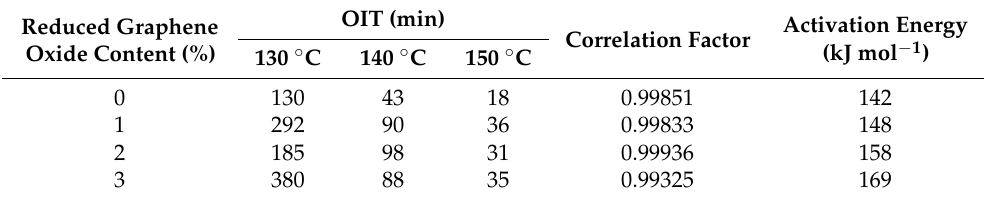
Table 2. Activation energies required for the oxidation of SIS improved with various amounts of reduced graphene oxide.